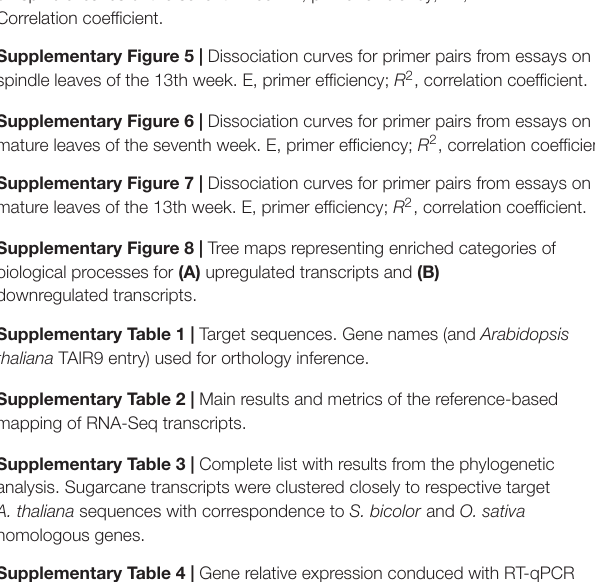
Supplementary Table 2 | Main results and metrics of the reference-based mapping of RNA-Seq transcripts. Supplementary Table 3 | Complete list with results from the phylogenetic analysis. Sugarcane transcripts were clustered closely to respective target